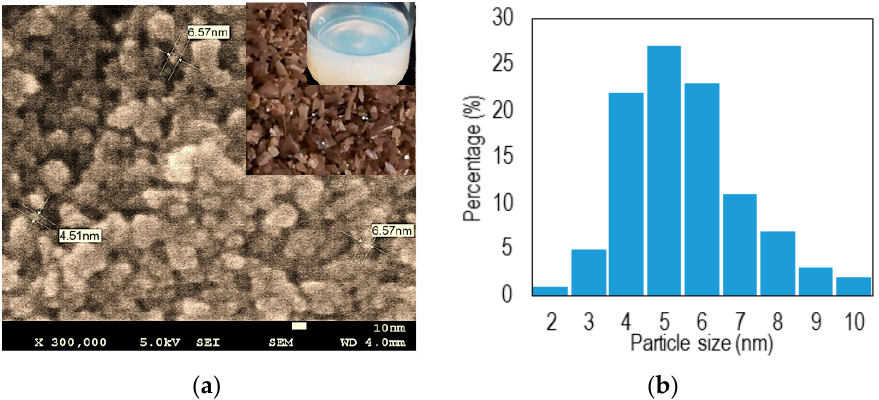
Figure 1. ( a ) The FESEM images of nano-anatase titanium dioxide (inset: the powder and its solution form); ( b ) Normalized distribution of the particle sizes.